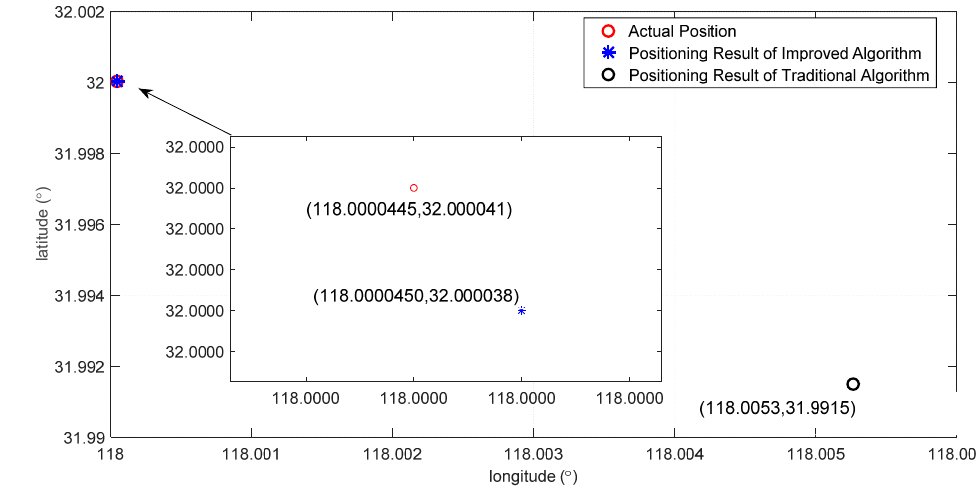
Figure 18. Comparison of the positioning results.